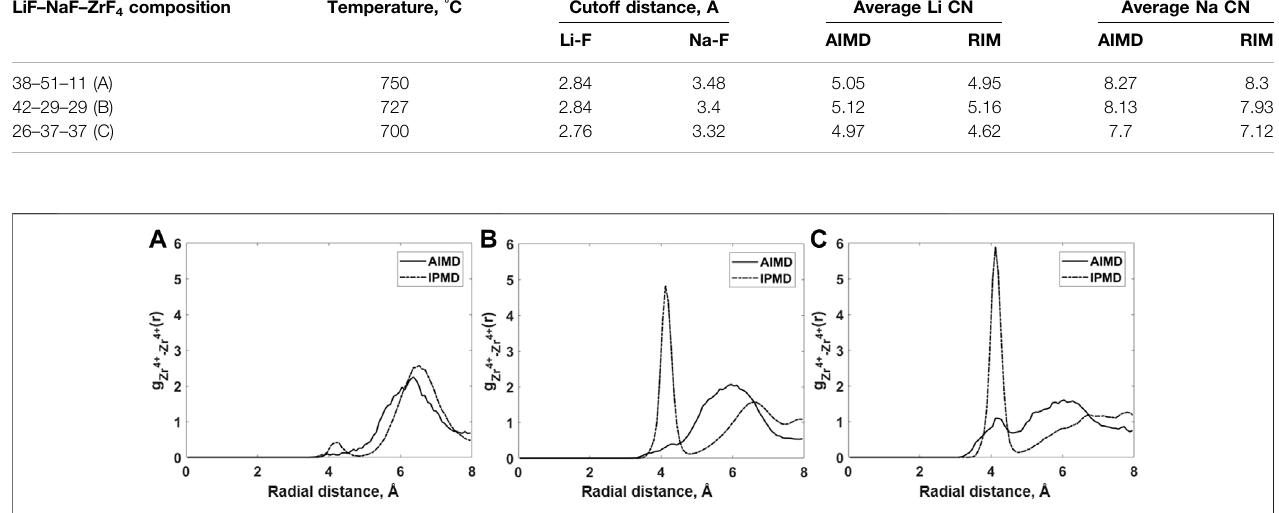
FIGURE 3 | Comparison of Zr – Zr radial distribution functions for (A) Composition A at 750 ° C, (B) Composition B at 727 ° C, and (C) Composition C at 700 ° C between AIMD and RIM IPMD calculations.